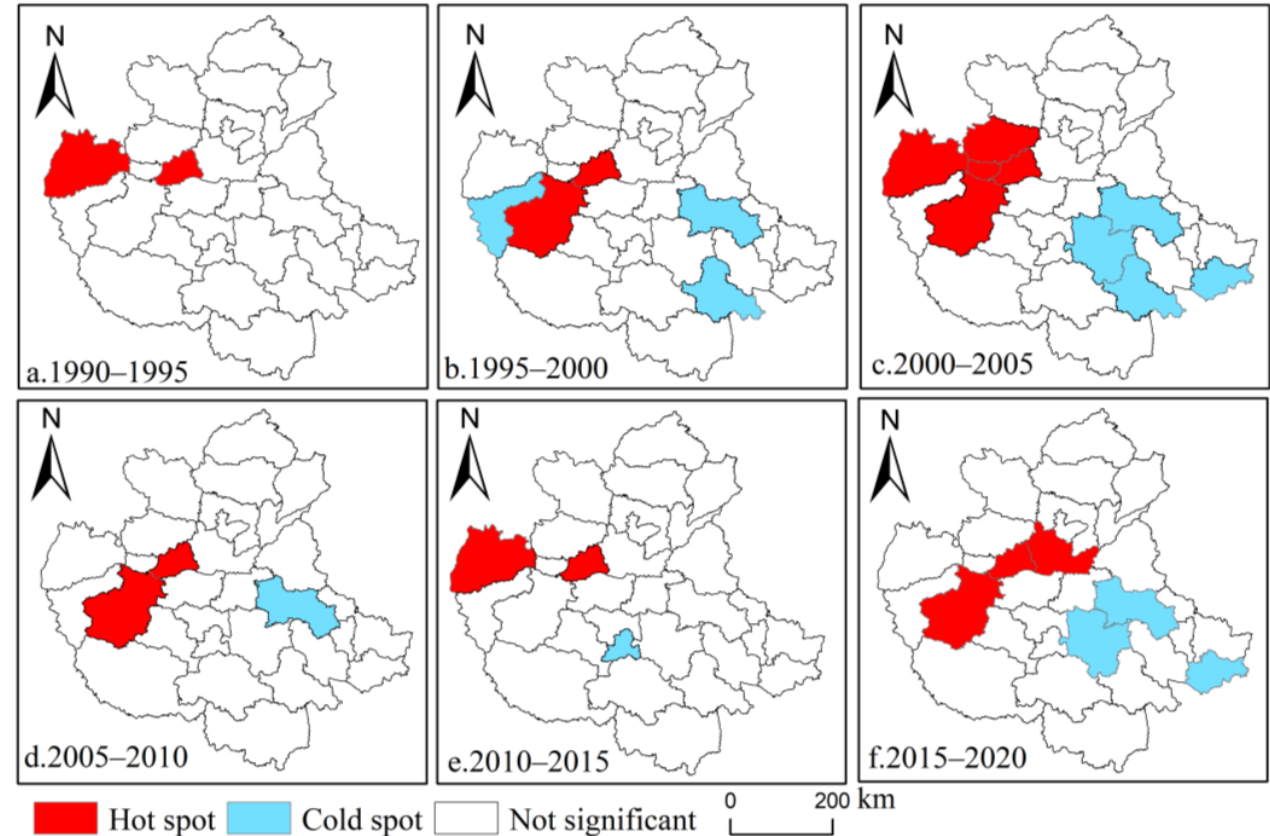
Figure 5. Evolution of hot and cold spots of urban spatial expansion. ( a ) 1990–1995 hot and cold spots of urban spatial expansion; ( b ) 1995–2000 hot and cold spots of urban spatial expansion; ( c ) 2000–2005 hot and cold spots of urban spatial expansion; ( d ) 2005–2010 hot and cold spots of urban spatial expansion; ( e ) 2010–2015 hot and cold spots of urban spatial expansion; ( f ) 2015–2020 hot and cold spots of urban spatial expansion.